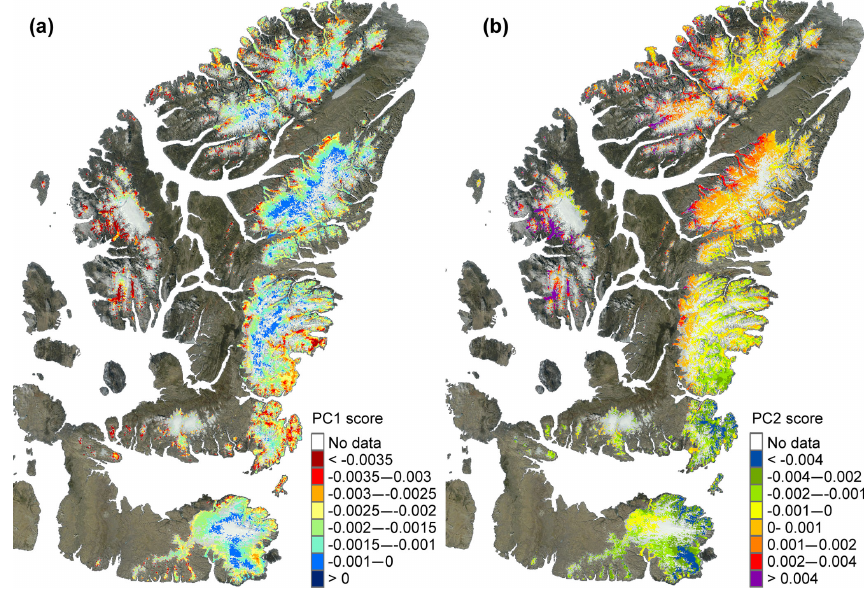
Figure 8. Component scores for the first two principal components of the mean summer clear-sky BSA (Fig. 2) over the QEI ice caps. Background image: MODIS, 4 July 2011. Brown indicates non-glaciated land cover. Table 3. QEI-wide (regionally averaged) BSA and LST change for the period 2001–2016; ± 1standard